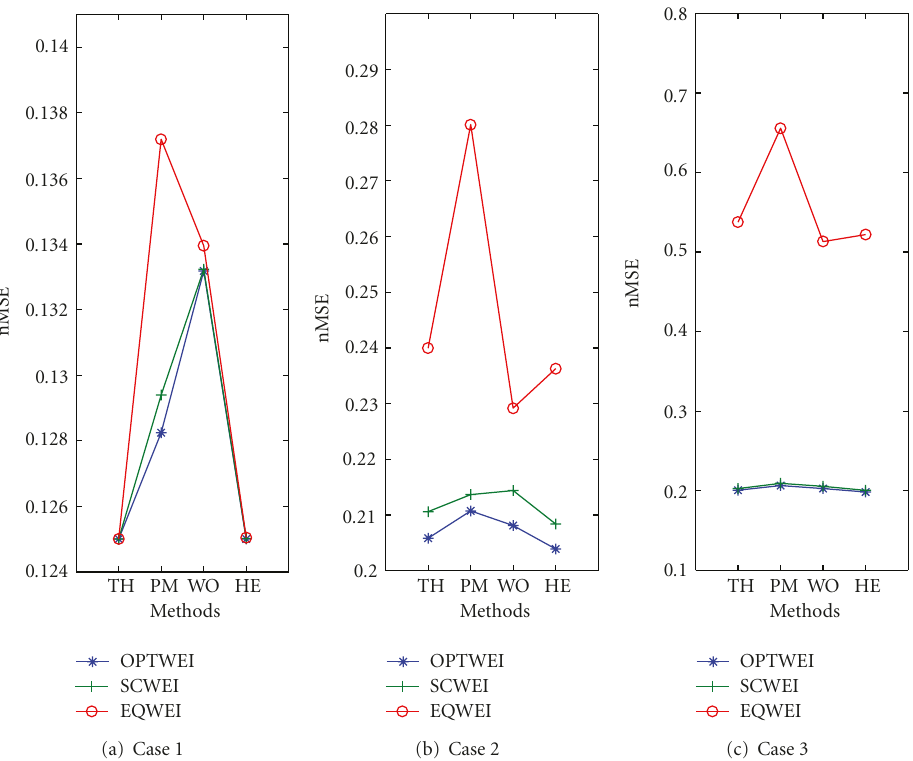
Figure 2: The normalized mean square error for the three bandlimited white noise processes with EQWEI (circles), SCWEI (pluses), and OPTWEI (stars) for di ff erent window sets, Thomson multiple windows (TH), Peak Matched multiple windows (PM), Welch method (WO), and Hermite functions (HE): (a) stationary process, (b) long-event nonstationary process, and (c) short-event nonstationary